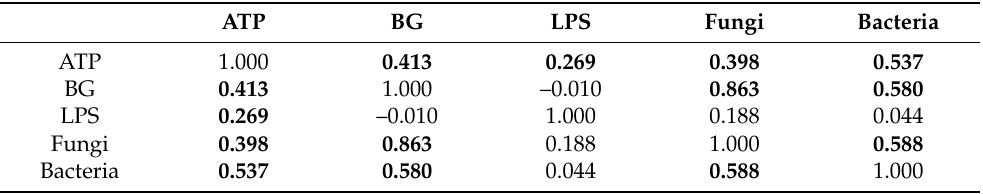
Table 1. Correlation (r) between biomass